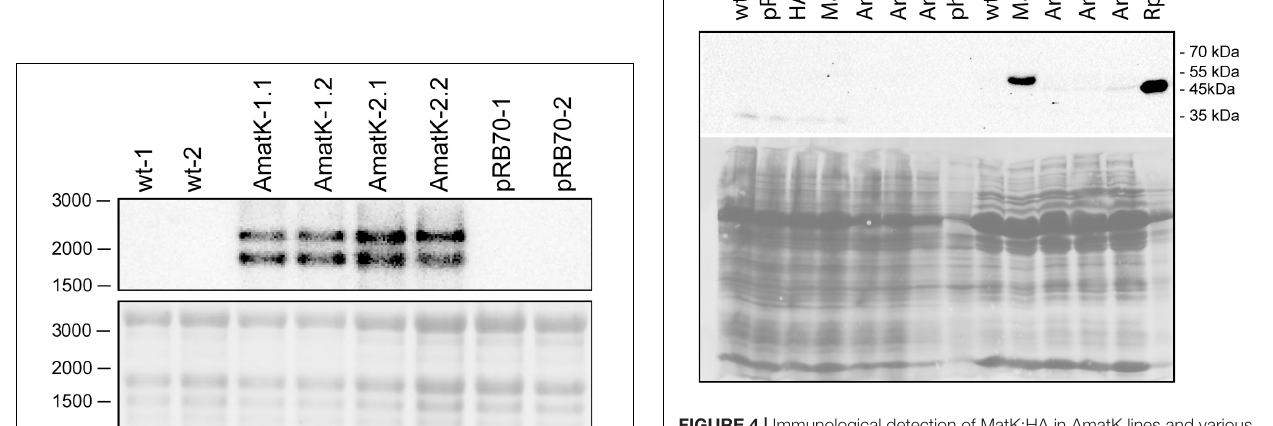
FIGURE 4 | Immunological detection of MatK:HA in AmatK lines and various controls. Top: Total leaf proteins were denatured and separated on a 12% polyacrylamid gel, blotted and probed with a rabbit anti-HA antibody. pRB70 = control lines containing an aadA -cassette, but no riboswitch cassette; HA:MatK = line with an N-terminal HA-tagged endogenous matK gene. MatK:HA = line with a C-terminal HA-tagged matK gene; theo = theophylline treated AmatK plant; phenocopy = wt plants treated with 17 mg/L spectinomycin; RpoA:HA = line with a C-terminally HA-tagged rpoA gene. Bottom: ponceau S stain of the blot shown